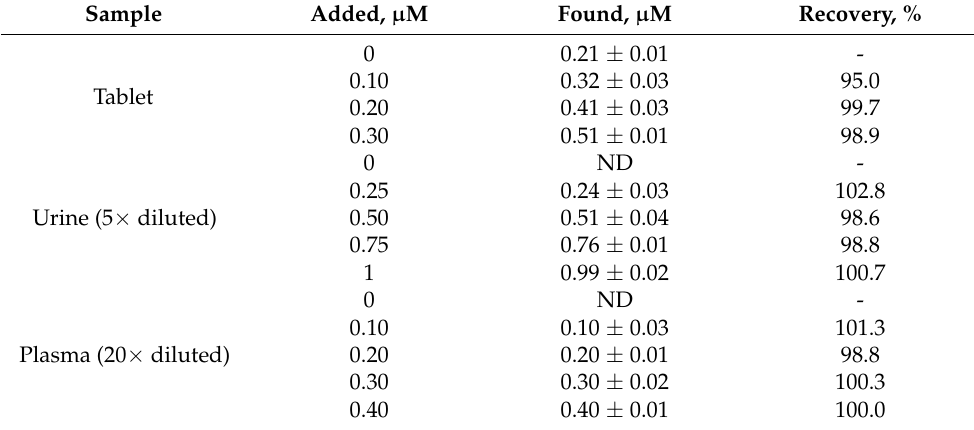
Figure 7. SWV vortioxetine calibration curves obtained for preconcentration times of (a) 5 s; (b) 10 s; (c) 15 s; (d) 20 s, and (e) 60 s ( A ), and corresponding voltammograms for the preconcentration time of 60 s ( B ). Other instrumental parameters as in point 2.7. Table 2. Results of vortioxetine determination in samples: tablets, urine, and plasma.